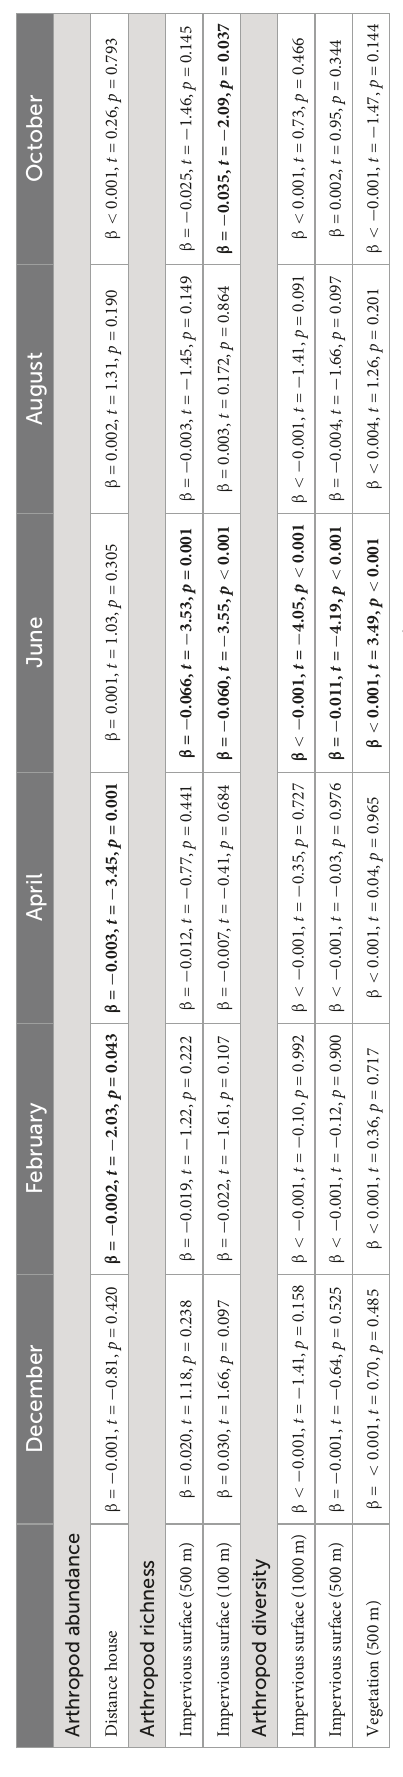
( Table 1A ): in the canopy and the bush layer, diversity decreased with increasing urbanisation level ( Table 1B ). For instance, the Shannon diversity index in the canopy was 1.93 (out of a maximum of 2.55) at less urbanised sites (i.e., sites for which impervious surface covered up to 13% of the land in a 1,000 m radius—the 1st quartile), while it was 1.58 (out of a maximum of 2.30) at highly urbanised ones (i.e., sites for which impervious surface covered more than 45% of the land in a 1000 m radius—the 3rd quartile) ( Figure 3 ). In the bush layer, it was 1.66 (out of a maximum of 2.31) and 1.59 (out of a maximum of 2.28) at less and highly urbanised sites, respectively ( Figure 3 ). In only three models, arthropod diversity was influenced by the interaction between urbanisation level and month ( Table 1A ): diversity decreased with increasing urbanisation level (impervious surface cover in a 500 and 1,000 m radius, or vegetation cover in a 500 m radius) in June only ( Table 1C ). In the remaining models, arthropod diversity varied between months ( Table 1A ); variations in arthropod diversity between months are detailed in Supplementary Appendix C